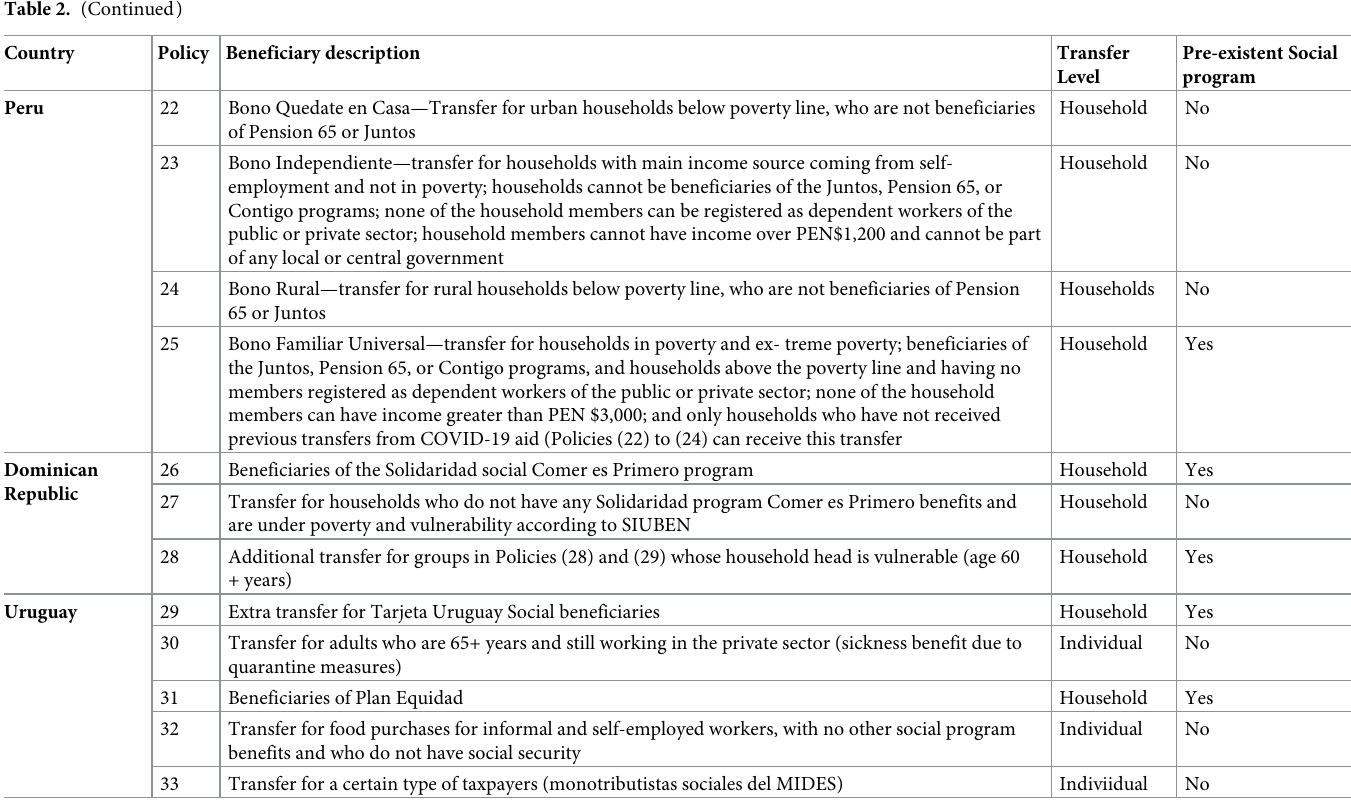
Table 3. Government expenses on social protection by country in 2019 and 2020 (LCU in millions).